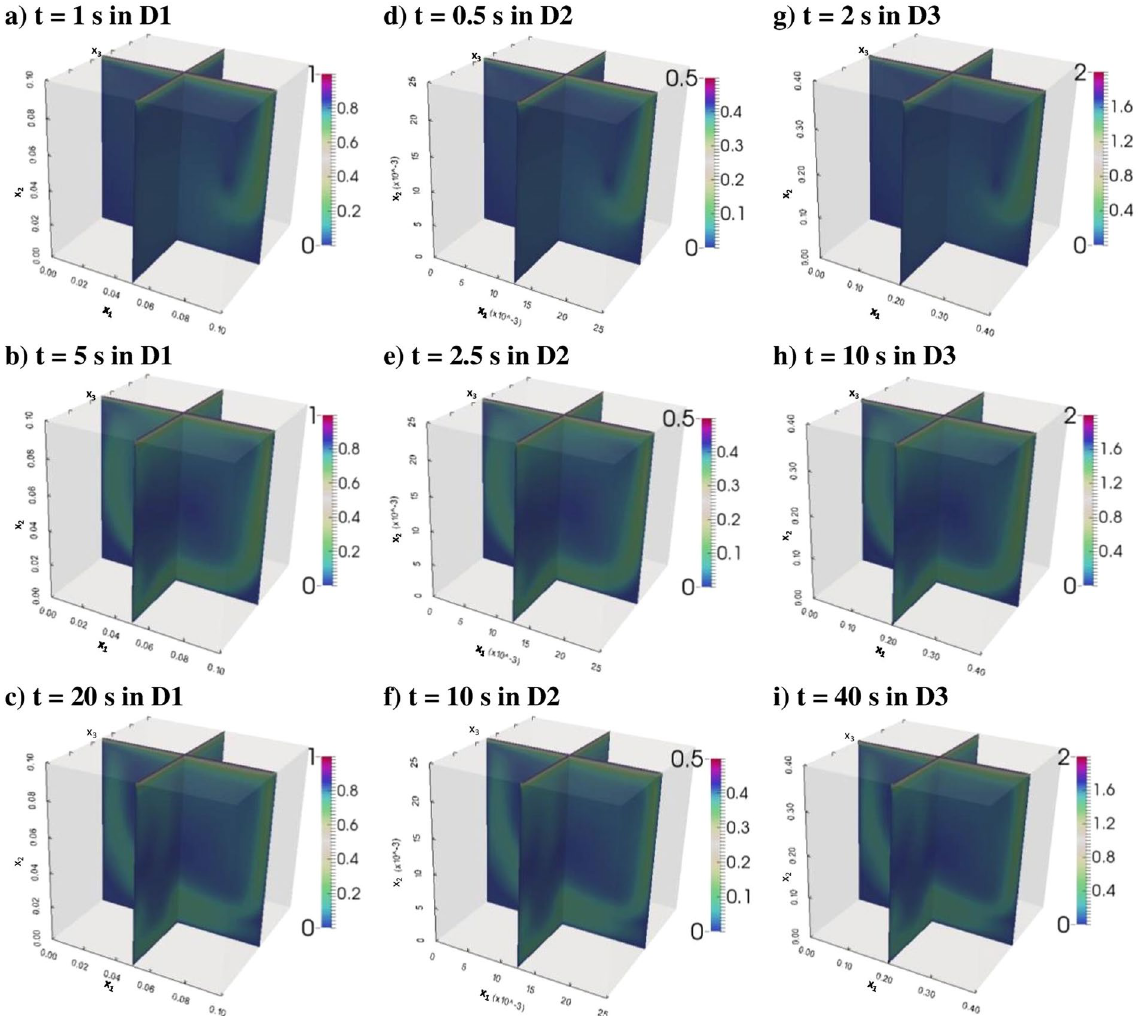
Figure 2. Contours of velocity magnitudes: at x = 0.05 m and z = 0.05 m in Domain 1 at simulation times of ( a ) 1 s, ( b ) 5 s, ( c ) 20 s; at x = 0.0125 m and z = 0.0125 m in Domain 2 at simulation times of ( d ) 0.5 s, ( e ) 2.5 s, ( f ) 10 s; at x = 0.2 m and z = 0.2 m in Domain 3 at simulation times of ( g ) 2 s, ( h ) 10 s, ( i ) 40 s. Velocity magnitudes within each row are self-similar to each other (Although the figures in each row look exactly similar, the edge lengths of the cubes and the velocity scales of the color bars are different for each domain, or